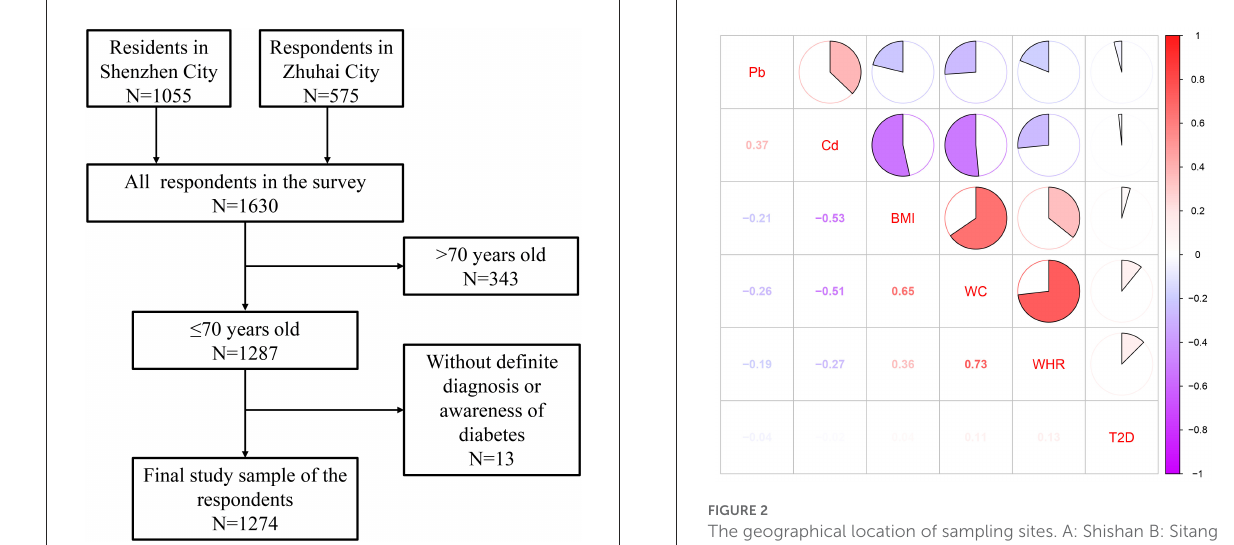
FIGURE1 Flow chart in the selection of study subjects.